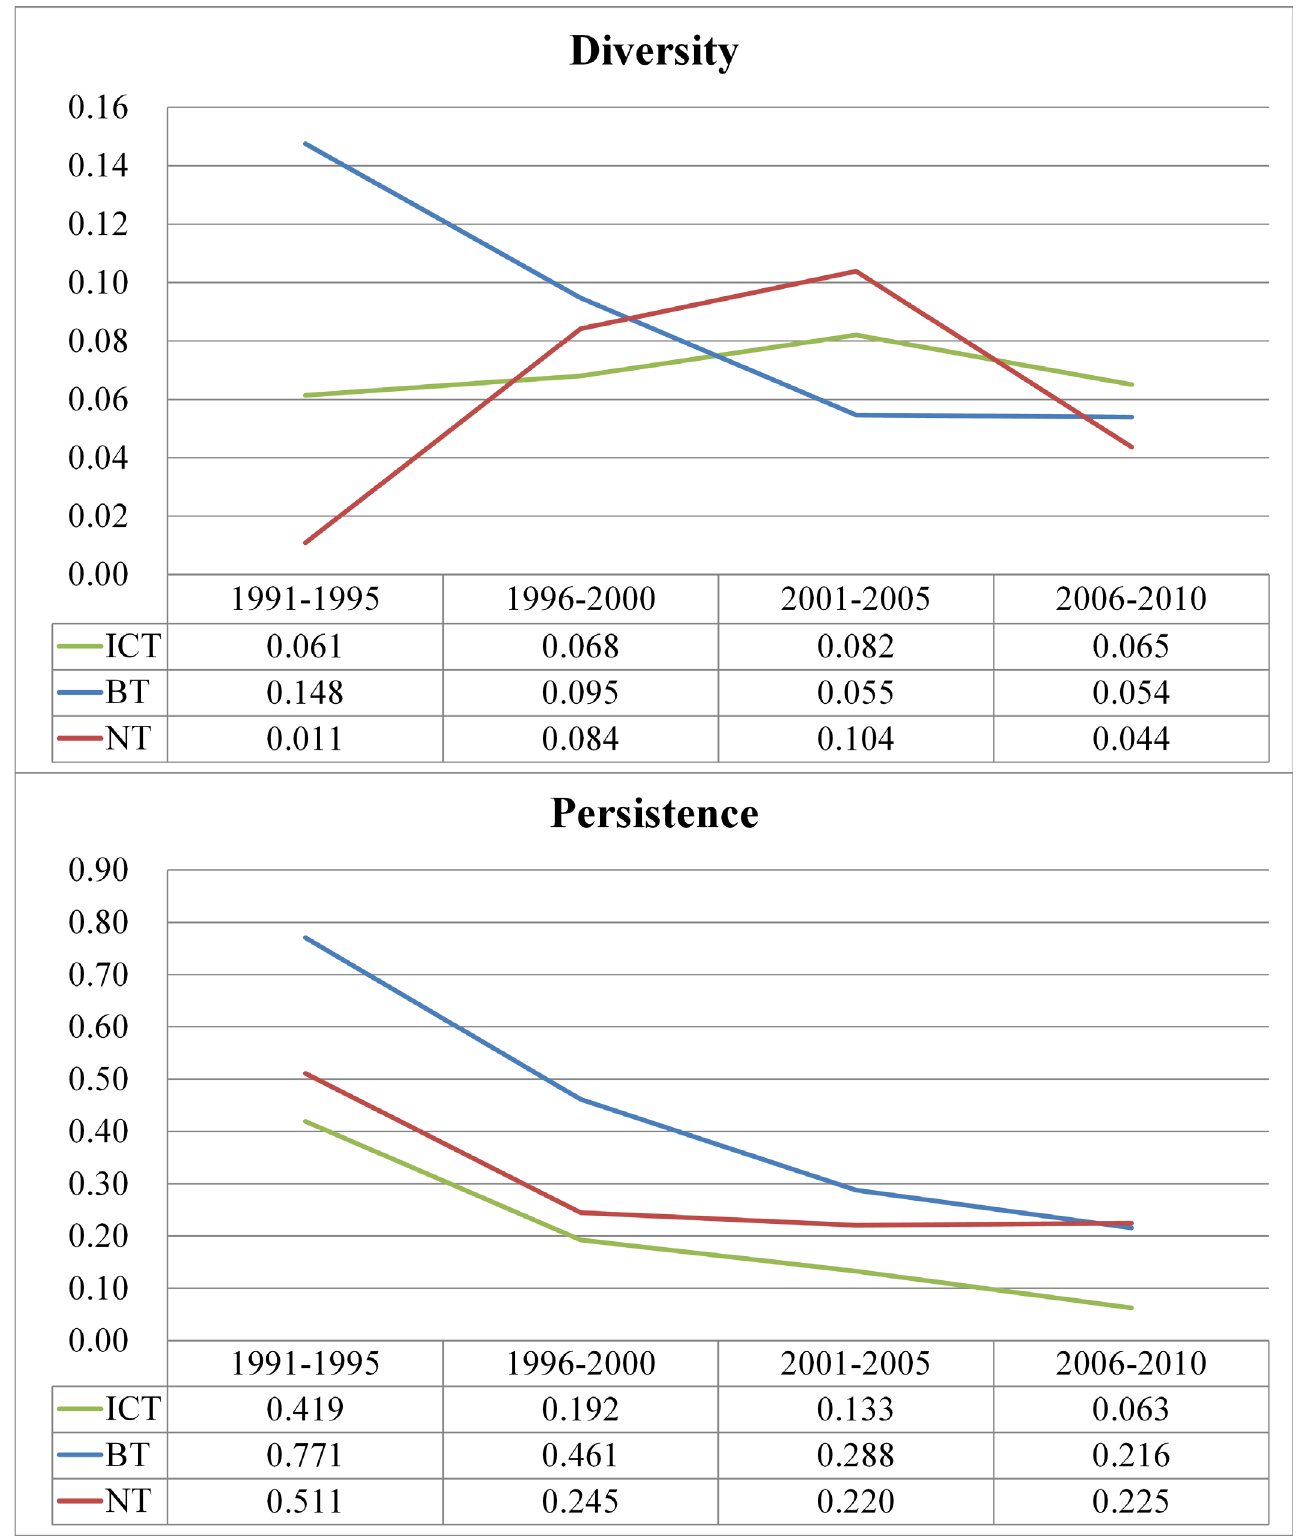
Fig 6. Pattern of Difference in Technology Convergence in ICT, BT, and NT Sectors between the US and Korea.